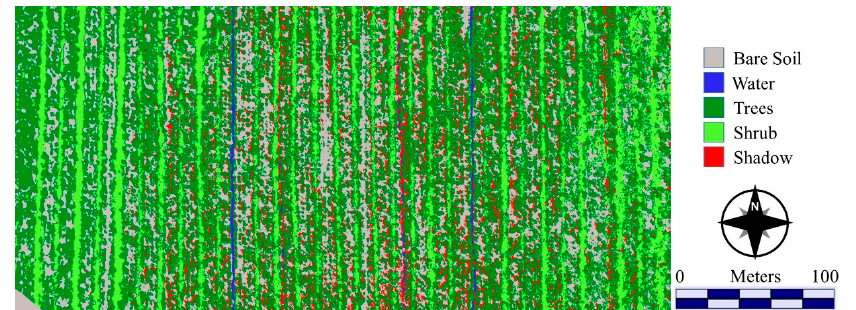
Figure 3. Land cover map of the study area. Table 1. Error matrix of the generated categorical map.